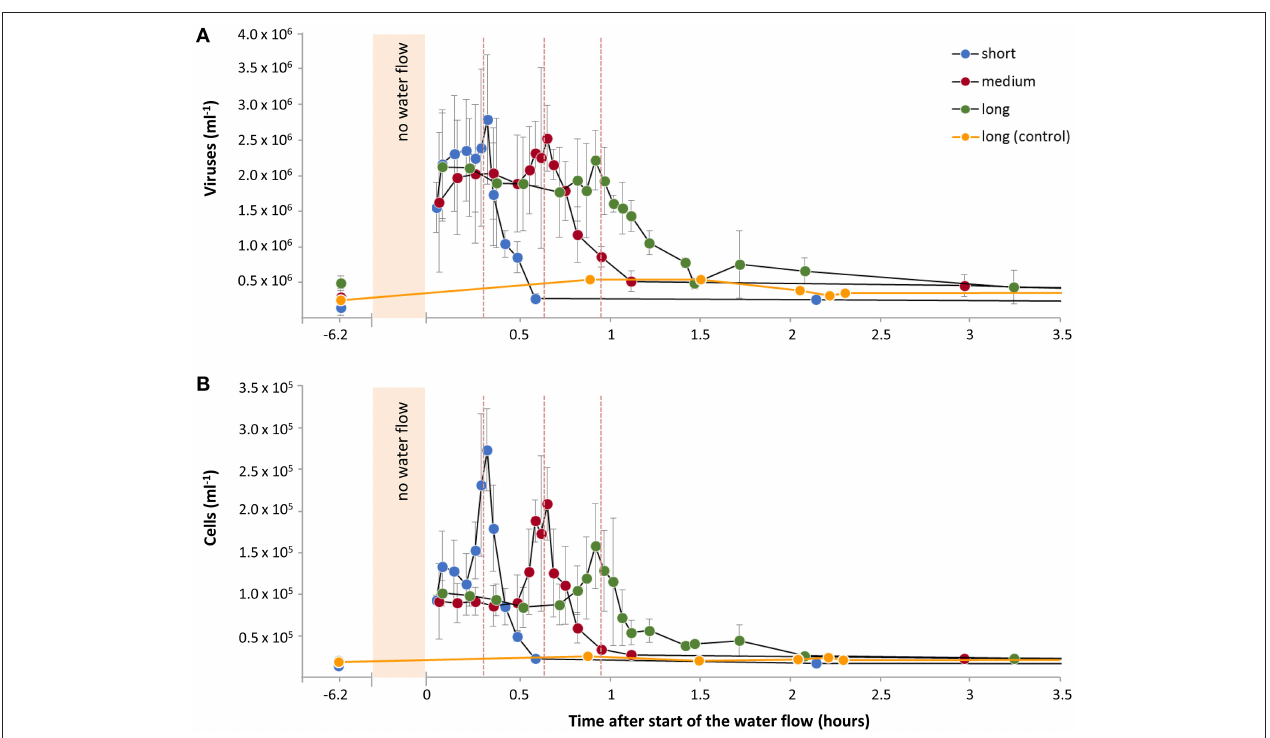
FIGURE 3 | Tidal simulation experiment with Janssand sediment (February) shown in detail after restart of the water flow. (A) Virus and (B) cell numbers in effluents (averaged of four tidal cycles) analyzed in reactors with different sediment columns lengths (short, medium, long). The water flow in the reactors was stopped for 6h followed by 6h with continuous water flow. The water flow was continuous in one long sediment column (control). Dotted vertical lines represent the time when one porewater volume had passed through the reactors after restart of the water flow, i.e., marking the water that had been present in the sediment surface during low tide.